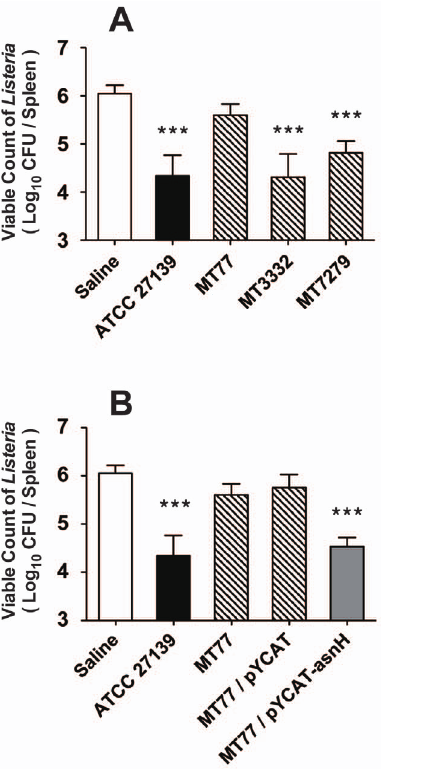
Figure 1. Anti-listerial activity of J1 phage-resistant Tn 5 insertion mutants of L. casei . Heat-killed preparations of L. casei ATCC 27139 or isogenic Tn 5 insertion mutants (800 m g) were injected i.v. into BALB/c mice 6 days before an i.v. challenge with L. monocytogenes (2.0 6 10 6 CFU/mouse). Six mice per group were dissected 24 h after the challenge, and viable Listeria were detected in spleens. Columns: white, saline; black, L. casei wild-type; slashed, L. casei J1 phage-resistant mutant; gray, L. casei asnH mutant comple- mented with the cloned asnH . Results are depicted as the means 6 standard deviations (SD). Statistical significance was calculated using the Student’s t -test. Significant differences indicated between the control and treated groups. ***, p , 0.001.